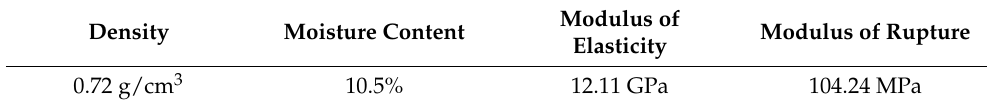
Table 1. Material properties of